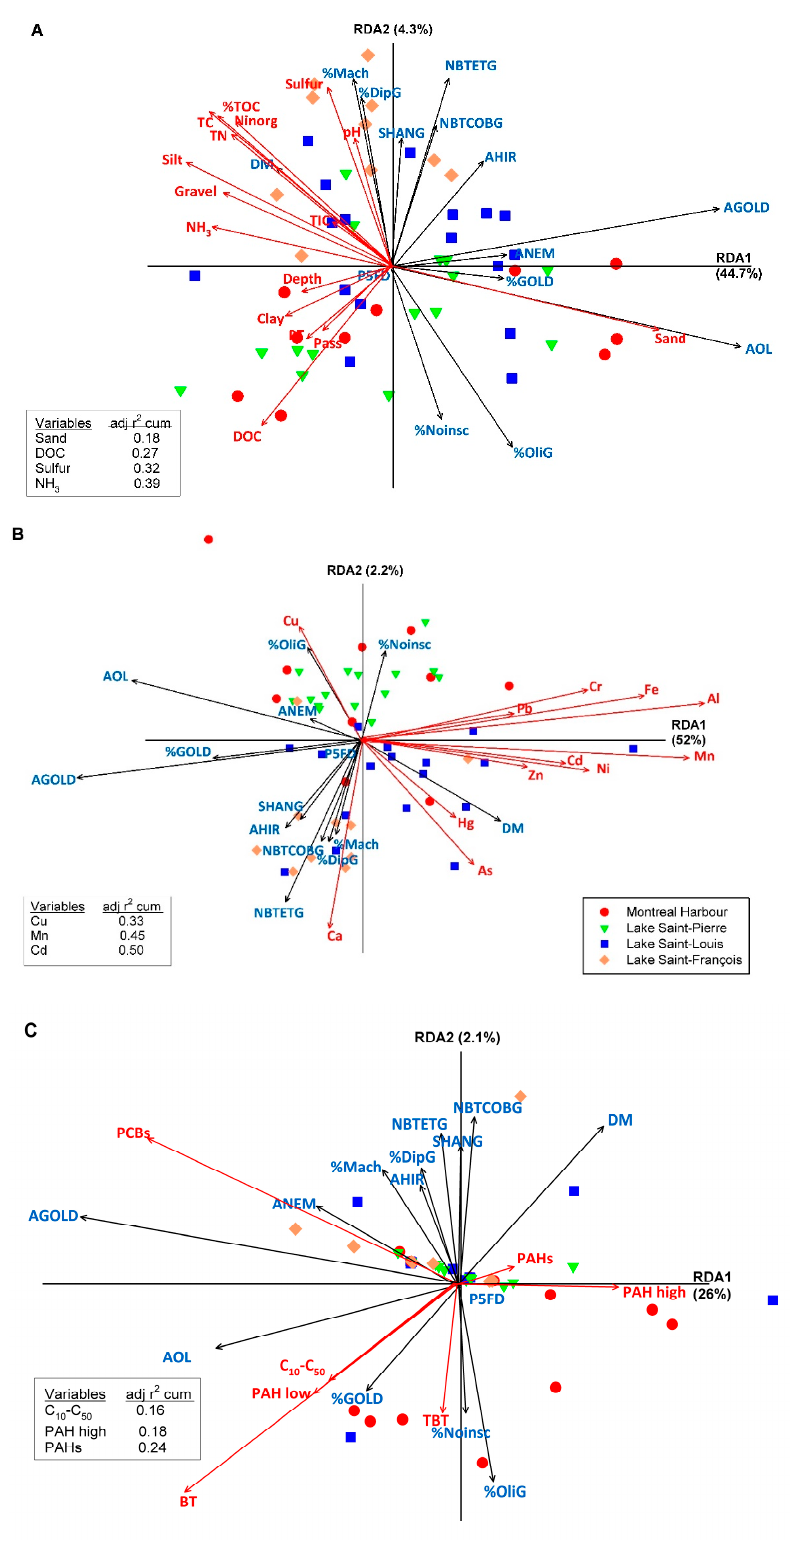
Figure 4. Redundancy analyses (RDA) based of the 14 selected indices and metrics and sediment characteristics and contaminants in 53 sampling sites of the three fluvial lakes and the Montreal harbour along the fluvial section of the St. Lawrence River. ( A ) sediment grain size composition and chemistry, ( B ) inorganic contaminants, ( C ) organic contaminants. Results without 6 outlier sites (LSL16, LSL17, LSL22, LSL26, PM28,